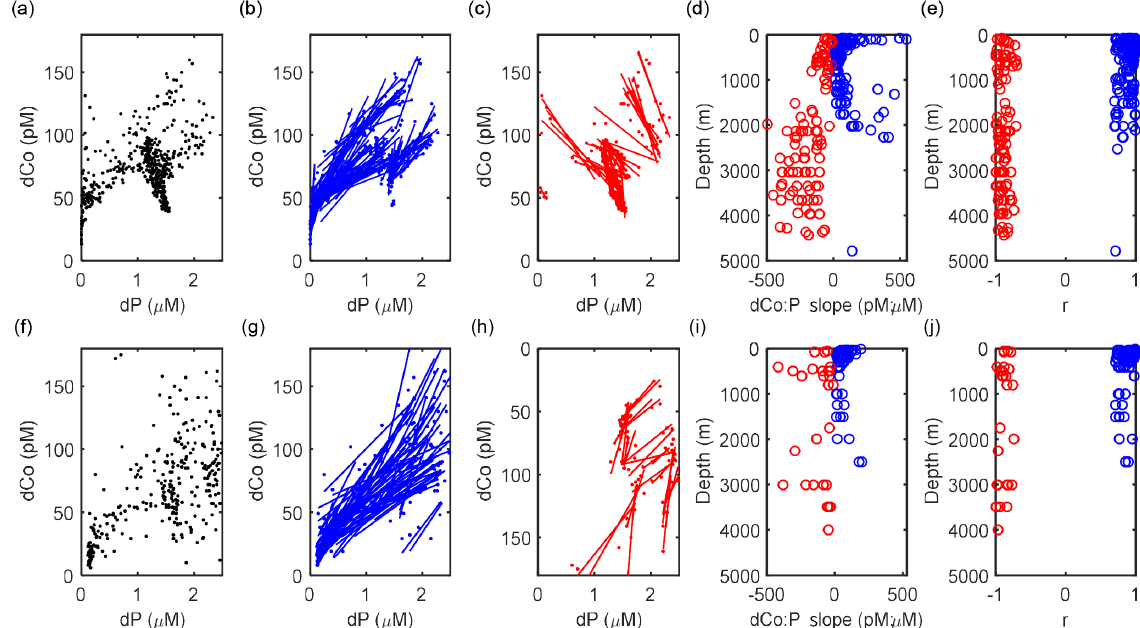
Figure 3. Five point moving window linear regression analyses of dissolved cobalt versus phosphate space. All data (a) and analyses (b– e) from the North Atlantic GA03/3_e section. All data (f) and analyses (g–j) from the South Atlantic GAc01 zonal section. (b, g) Data with a positive slope and r values greater than 0.7, after applying linear regressions on groups of five vertically adjacent data points within each profile across the entire transect. Solid blue lines represent the linear regressions superimposed on the data points analyzed. (c, h) Data with a negative slope and r values less than − 0.7, after applying linear regressions on groups of five vertically adjacent data points within each profile across the entire transect. Solid red lines represent the linear regressions superimposed on the data points analyzed. (d, i) Linear regression slopes versus depth for the five-point groupings; blue and red symbols represent positive and negative slopes, respectively. (e, j) r values (> | 0 . 7 | ) used in the analyses relative versus